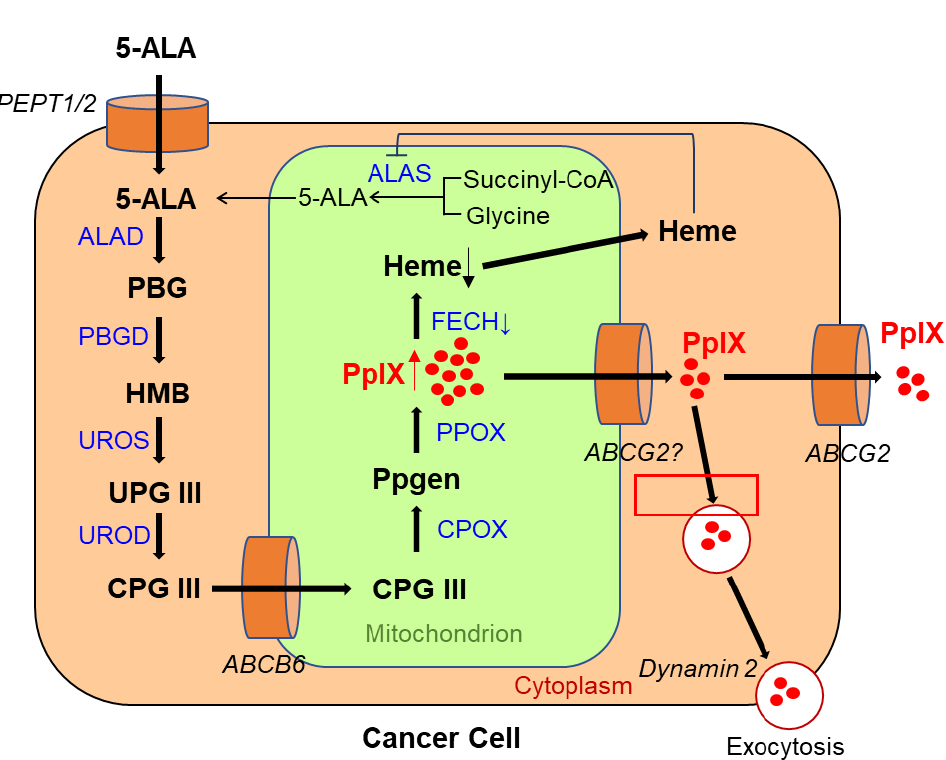
Figure 1. Metabolic pathways of 5-aminolevulinic acid (5-ALA) and mechanism of protoporphyrin IX (PpIX) accumulation in a viable cancer cell. PEPT 1/2, peptide transporter 1/2; ALAS , aminolevulinic acid synthase; ALAD, ALA dehydratase; PBG, porphobilinogen; PBGD, porphobilinogen deaminase; HMB, hydroxymethylbilane; UROS, uroporphyrinogen III synthase; UPG III, uroporphyrinogen III;